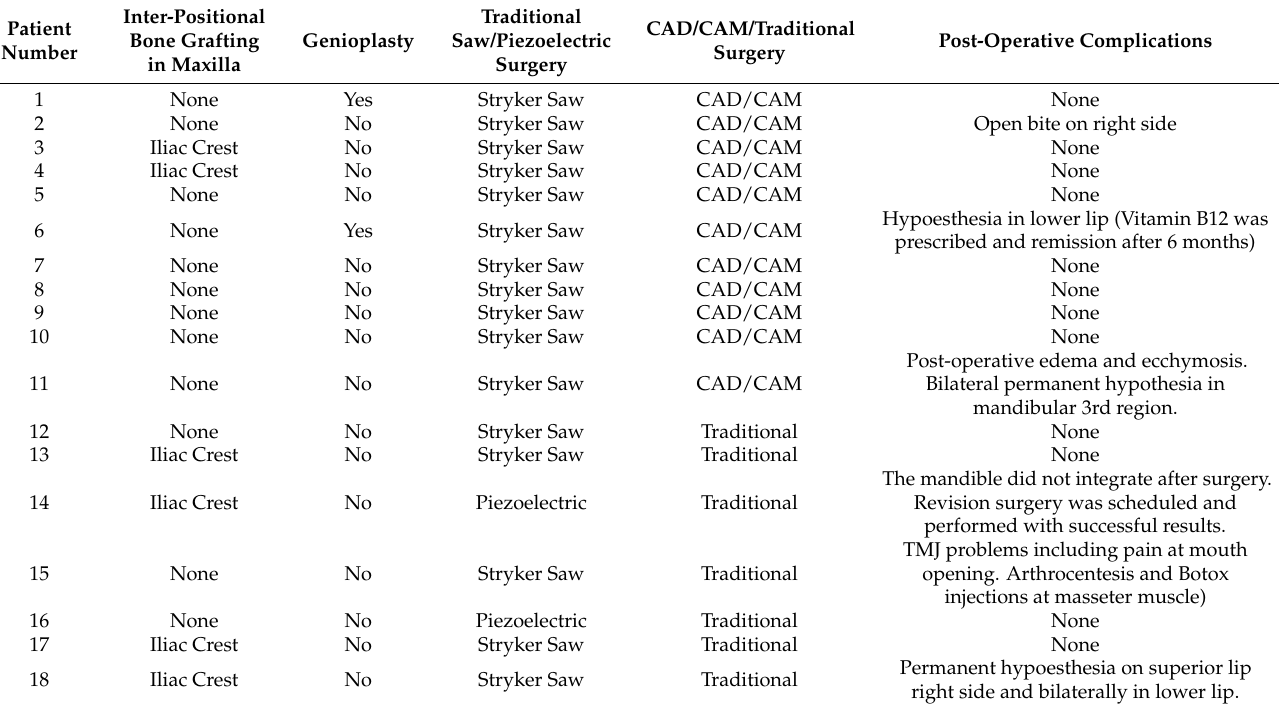
Table 4. Characteristics of surgical interventions and list of